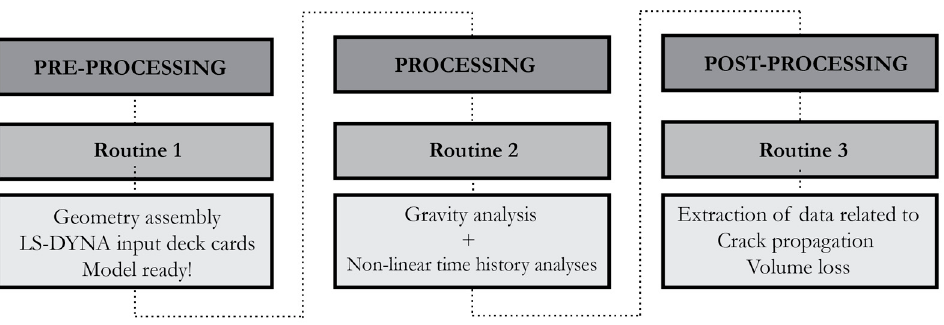
Figure 8. Procedure utilizing the automated algorithms in LS-DYNA for pre-processing, processing, and post-processing of the building models.